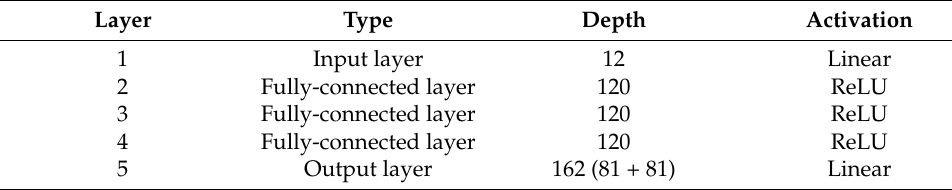
Figure 3. The flowchart of the proposed ANN. Table 3. The configuration of the proposed artificial neural network.